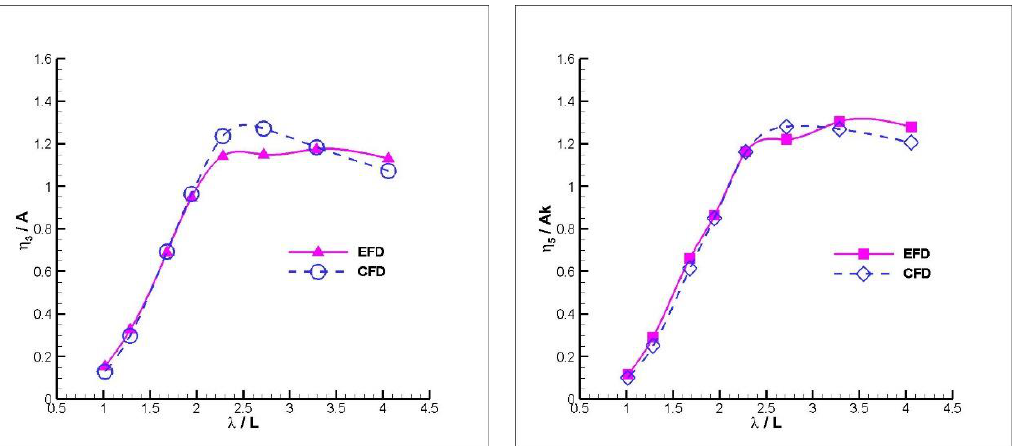
= 1.67. J. Mar. Sci. Eng. 2020 , 8 , x FOR PEER REVIEW B